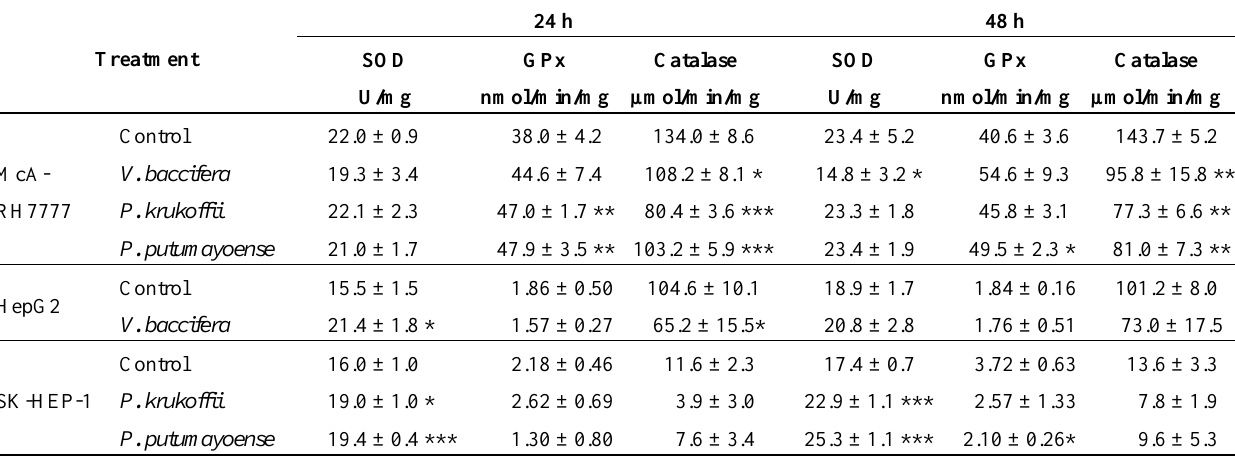
Table 3. Antioxidant enzyme activities in hepatoma cell lines exposed to V. baccifera (75 µg/mL), P. krukoffii (150 µg/mL), and P. putumayoense (150 µg/mL) leaf extracts for 24 and 48 h. Results are the mean ± SE of n = 3–9. * p < 0.05; ** p < 0.01; *** p < 0.005, significantly different from